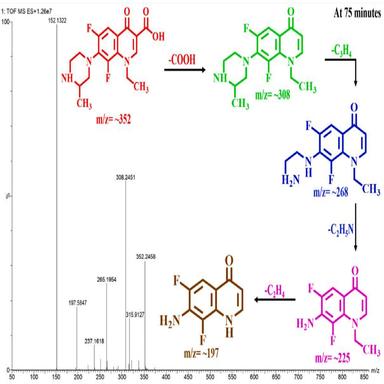
Electrospray ionization mass spectrometry (ESI (+) MS/MS) of LMF after 75 min of photocatalysis using AgFeO2/GO3. Inset: plausible pathway of LMF degradation.